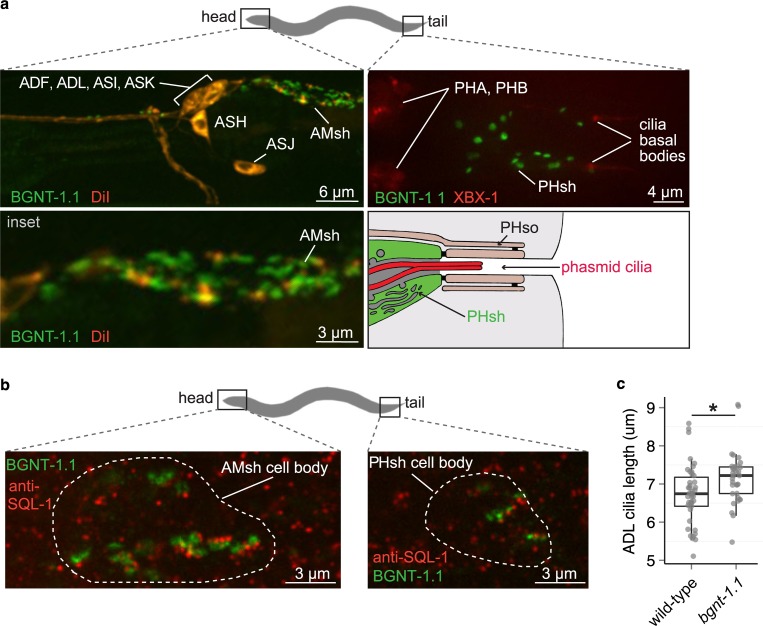
BGNT-1.1 localises to the trans-golgi in the amphid and phasmid sheath cells.(A) BGNT-1.1::GFP generated from a recombineered fosmid localises to the amphid and phasmid sheath cells. Amphid ciliated neurons (ADF, ADL, ASH, ASI, ASJ, and ASK) were visualised with DiI, while phasmid ciliated neurons (PHA and PHB) were visualised with Posm-5::XBX-1::tdTomato. Amphid sheath cells are abbreviated to AMsh, and phasmid sheath cells are abbreviated to PHsh. (B) BGNT-1.1::GFP localises proximal to the discrete anti-SQL-1 puncta. SQL-1 is an established cis-Golgi marker, indicating that BGNT-1.1 is concentrated at the trans-Golgi. (C) ADL cilia are significantly longer in bgnt-1.1 mutants compared to wild-type (p < 0.01, Kruskal-Wallis test). ADL cilia are labelled with Psrh-220::IFT-20::tdTomato. IFT-20 (IFT20) localises to cilia basal bodies and axonemes. The srh-220 promoter drives expression primarily in ADL neurons.